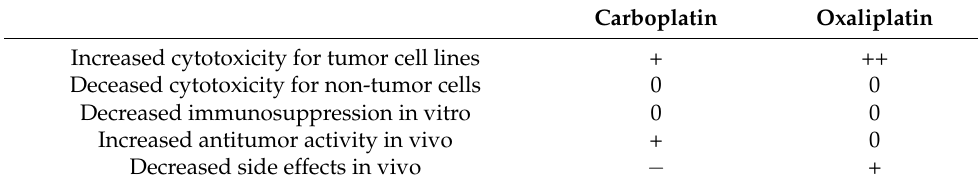
Table 3. Effects of CB[7] on the biological properties of platinum drugs. Carboplatin Oxaliplatin Increased cytotoxicity for tumor cell lines + ++ Deceased cytotoxicity for non-tumor cells 0 0 Decreased immunosuppression in vitro 0 0 Increased antitumor activity in vivo + 0 Decreased side effects in vivo −